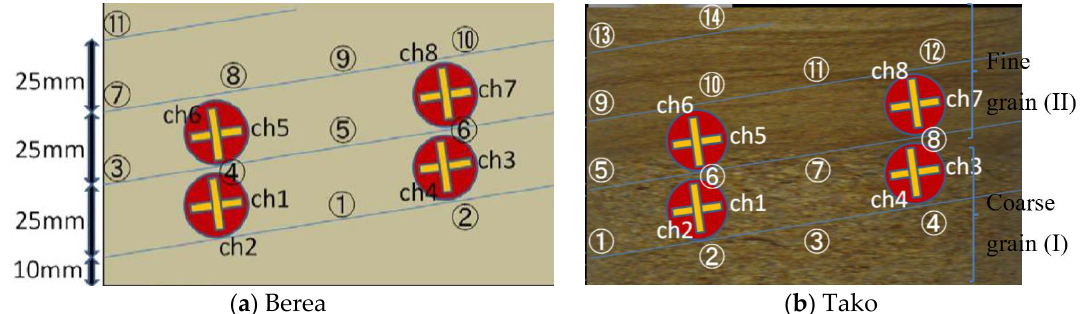
Figure 2. A schematic showing the position of the four strain gauges in relation to the optic fiber (blue line): ( a ) Berea sandstone core; ( b ) Tako sandstone core. Also shown is the position of the selected points where the frequency shifts are monitored.